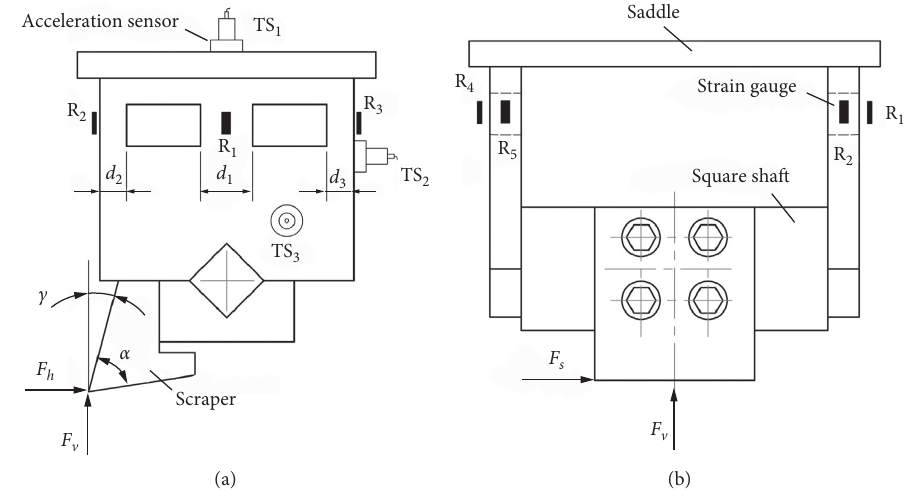
Figure 1: Illustration of sensors attached on the